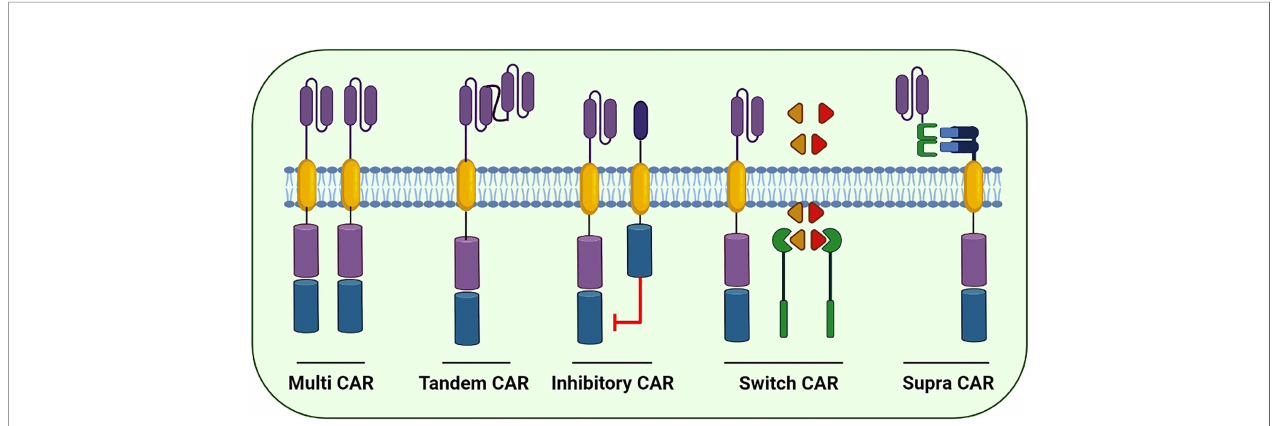
FIGURE 5 | Few of the next generation CARs to better cope with the immune escape and improve the cytotoxic potential of CAR-based immunotherapies: Multi CARs are equipped with two or more separate CARs expressing various ScFvs to target the cancer cells. Tandem CARs are equipped with two different scFvs in a single CAR molecule. Upon antigen recognition in healthy cells, Inhibitory CARs tend to inhibit immune cell activation. In switch CARs, certain chemicals capable of dimerization with the iCasp9 are conditionally administered to activates the downstream caspase molecules leading to the apoptosis of CAR-expressing cells. Supra CARs are equipped with two split structures; the antigen-binding domain (zipFV) and function domain (zipCAR) that upon binding activates the CAR-expressing cells.